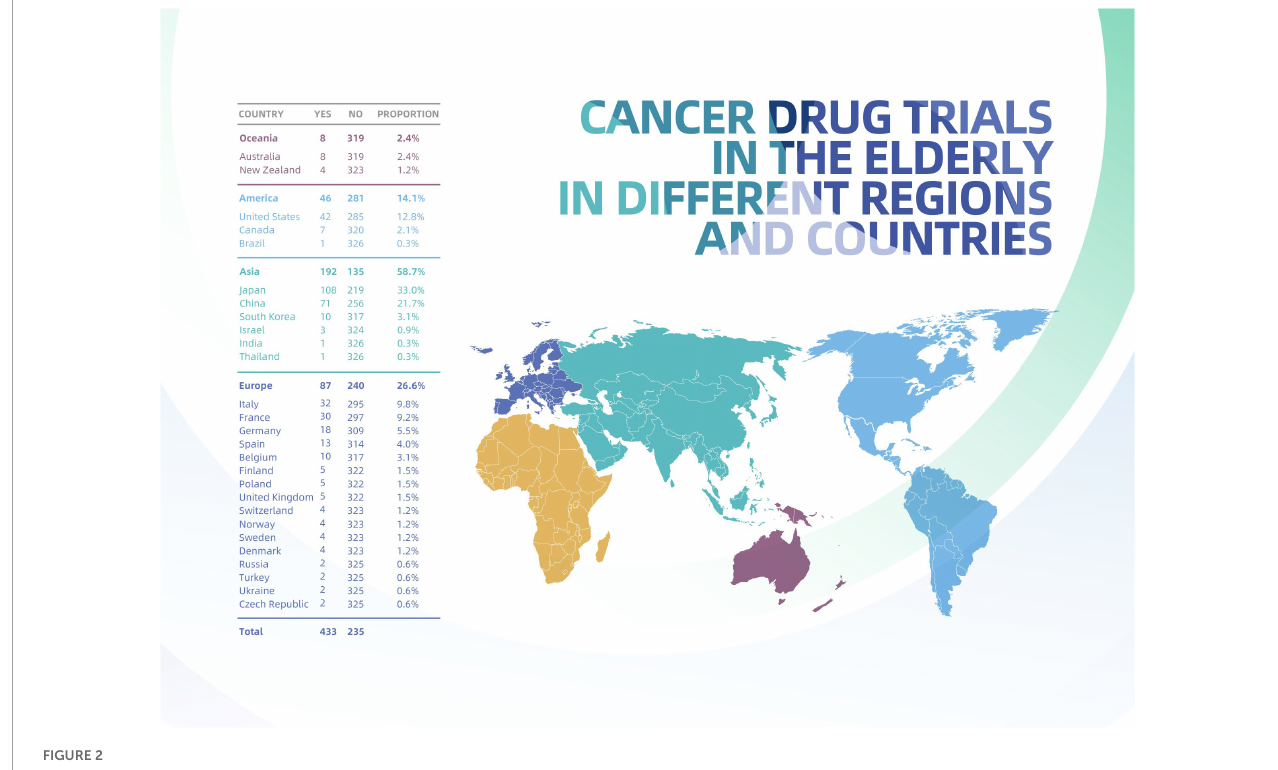
FIGURE2 Geriatric drug trials on solid tumor by continent and country.